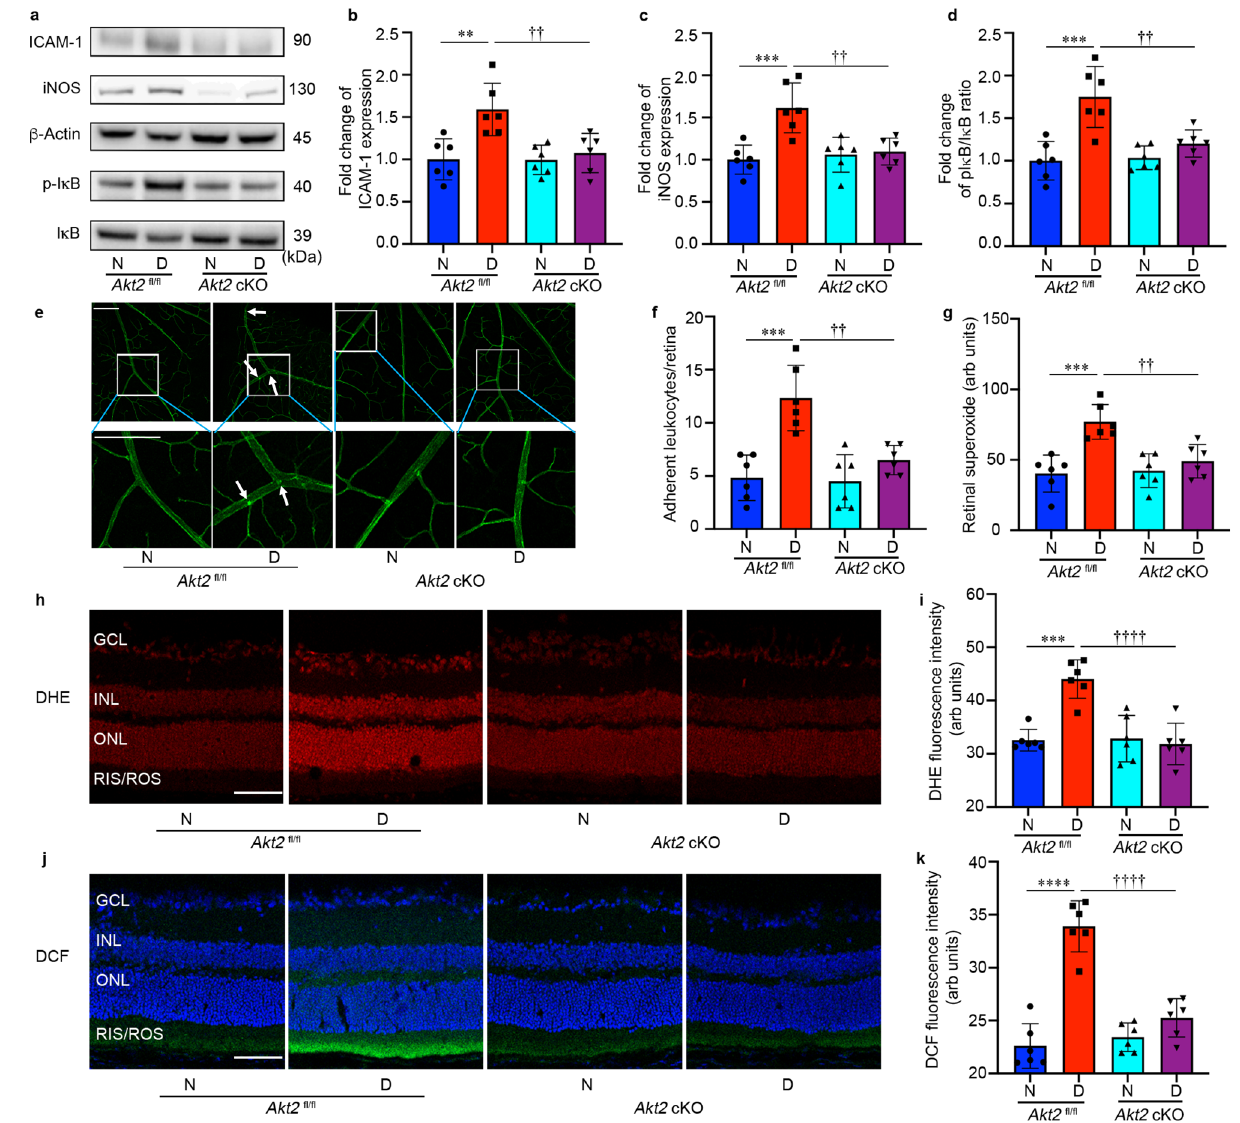
Fig. 2 | RPE-speci fi c Akt2 cKO inhibits the diabetes-induced increases in in fl ammatoryproteins,leukostasis,andgenerationofreactiveoxygenspecies in the mouse retina after 2 months of diabetes. a Representative immunoblots and densitometry graphs demonstrating the diabetes-induced increases of ( b ) ICAM-1, ( c ) iNOS, and ( d ) the ratio of pI κ B/I κ B were inhibited in the retina of RPE- speci fi c Akt2 cKO diabetic mice. e Representative imagesand ( f ) quanti fi cation of attached leukocytes in the retina. Arrows indicate leukocytes adherent to the retinal blood vessels. Diabetes increased the number of adherent leukocytes in the Akt2 fl / fl diabetic retina compared to nondiabetic Akt2 fl / fl mice; this number was markedly reduced in Akt2 cKO diabetic mice, Scale bar: 100 µ m. g Retinal superoxide was measured using lucigenin; diabetes increased retinal production of superoxide in Akt2 fl / fl mice. These levels were attenuated in Akt2 cKO diabetic mice. h Representative images and ( i ) quanti fi cation of DHE-stained (red) retinal sections showing the levels of ROS in each group. The DHE stain was primarily localized in the nuclear layers, Scale bar: 100 µ m. The intensity of red fl uores- cence was quanti fi ed at the INL and ONL as they represent the majority of red staining in the retina. The diabetes-induced increase of ROS in Akt2 fl / fl retina was not observed in diabetic Akt2 cKO mice. j Representative images and ( k )